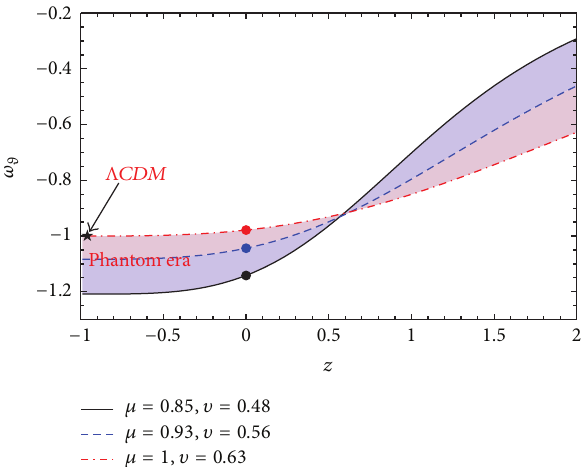
Figure 15: Evolution trajectories of EoS parameter in NHDE for different values of parameters (𝜇,𝜐) with −1 ≲ 𝑧 ⩽ 2 . The dot denotes the present day, and star represents the Λ CDM